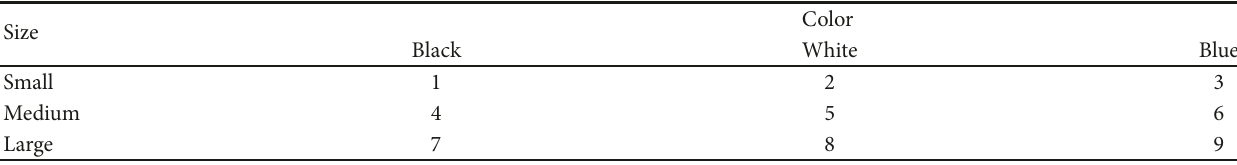
Table 1: Numbering the downjacket based on different size and color.